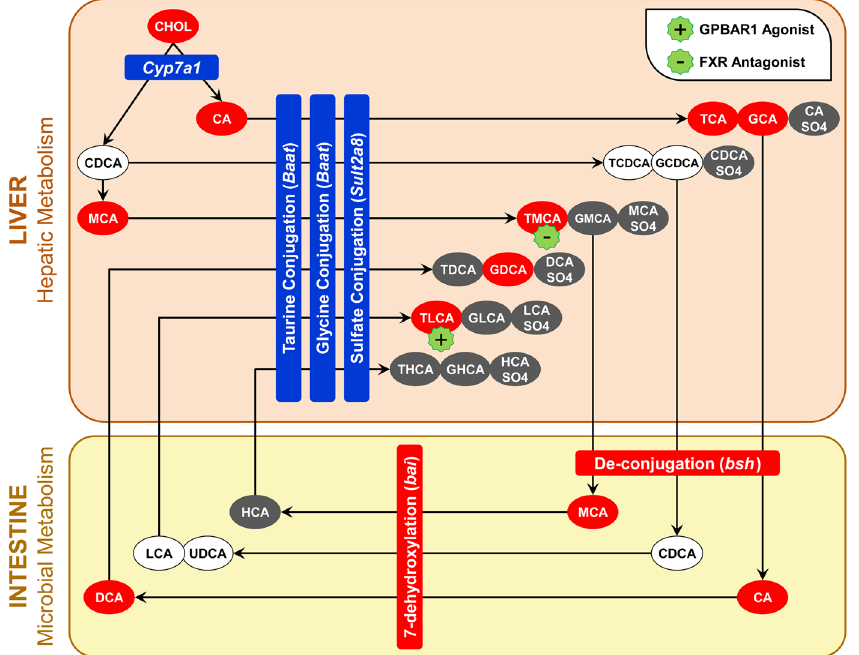
Figure 9. The effect of TCDD on the hepatic and microbial metabolism of individual bile acid species in male C57BL/6 mice orally gavaged with sesame oil vehicle or TCDD every 4 days for 28 days. Ovals represent bile acid species, while rectangles represent genes involved in bile acid metabolism. Placement of genes within the ‘liver’ and ‘intestine’ boxes represents the location of the metabolic reaction and the source of the enzyme involved. Red represents ‘increased levels’, blue represents ‘decreased levels’, white represents ‘no change’, and grey represents ‘not detected’. The color of each bile acid depicts the direction of change within the liver and/or serum relative to vehicle